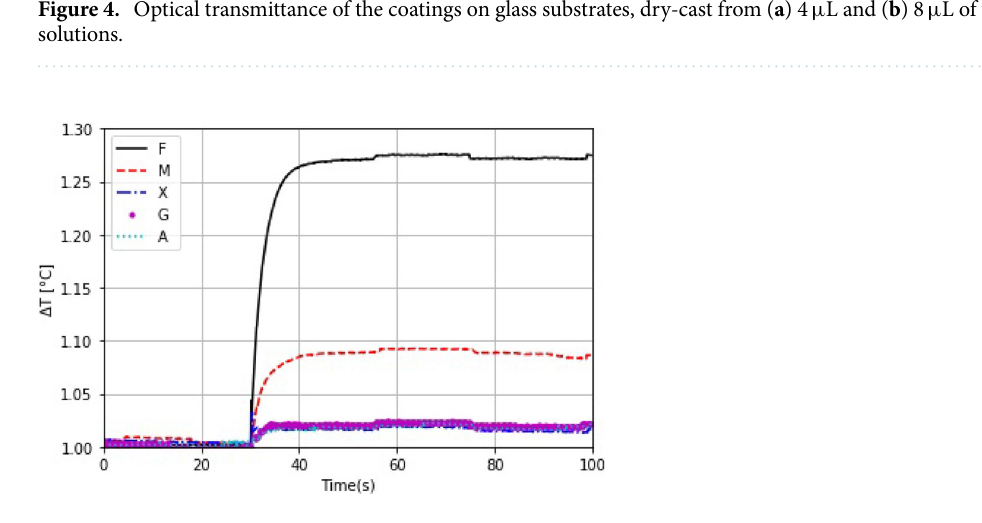
Figure 5. The normalized temperature change � T (